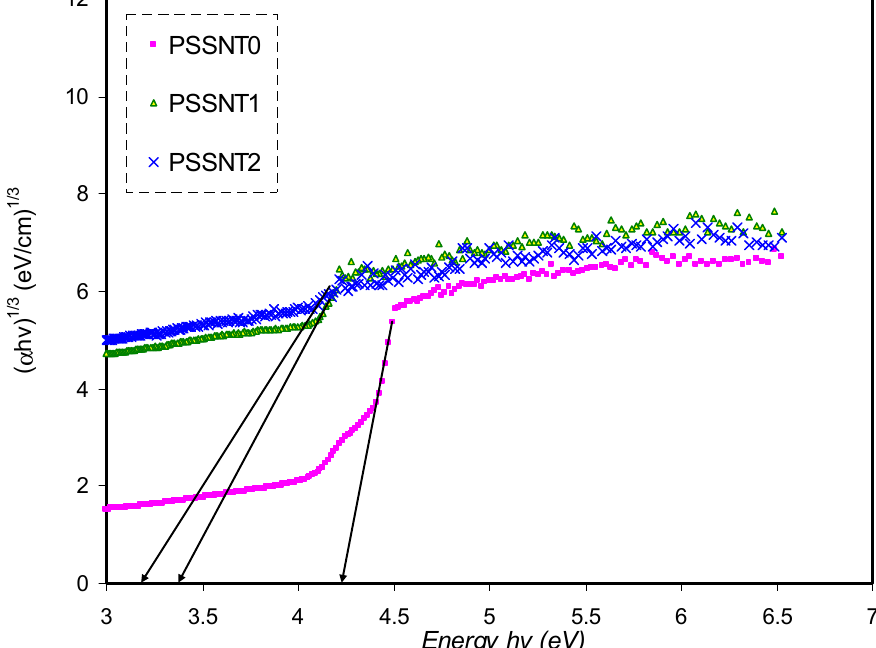
Figure 13. Plot of ( α h υ ) 1 / 3 versus photon energy for pure PS (PSSNT0), PSSNT1, and PSSNT2 NC films. Table 5. Band gap E g from Tauc’s method ( α h υ ) 1/ γ versus photon energy h υ and the optical dielectric loss ε″ plot, where α represents the absorption coefficient.